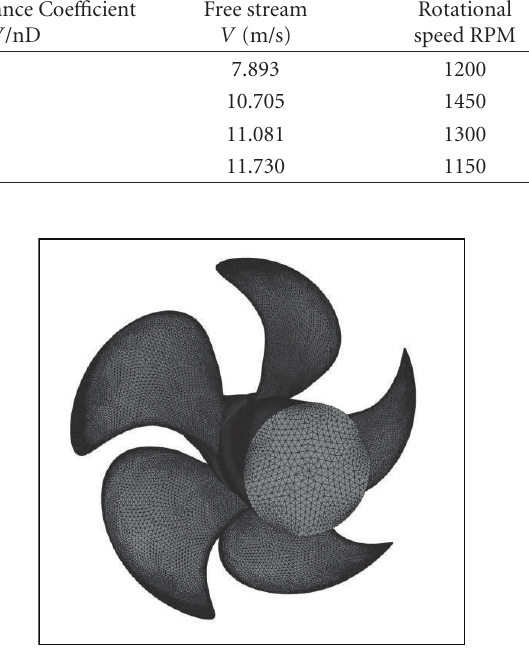
Figure 8: Geometric and surface grid for marine propeller